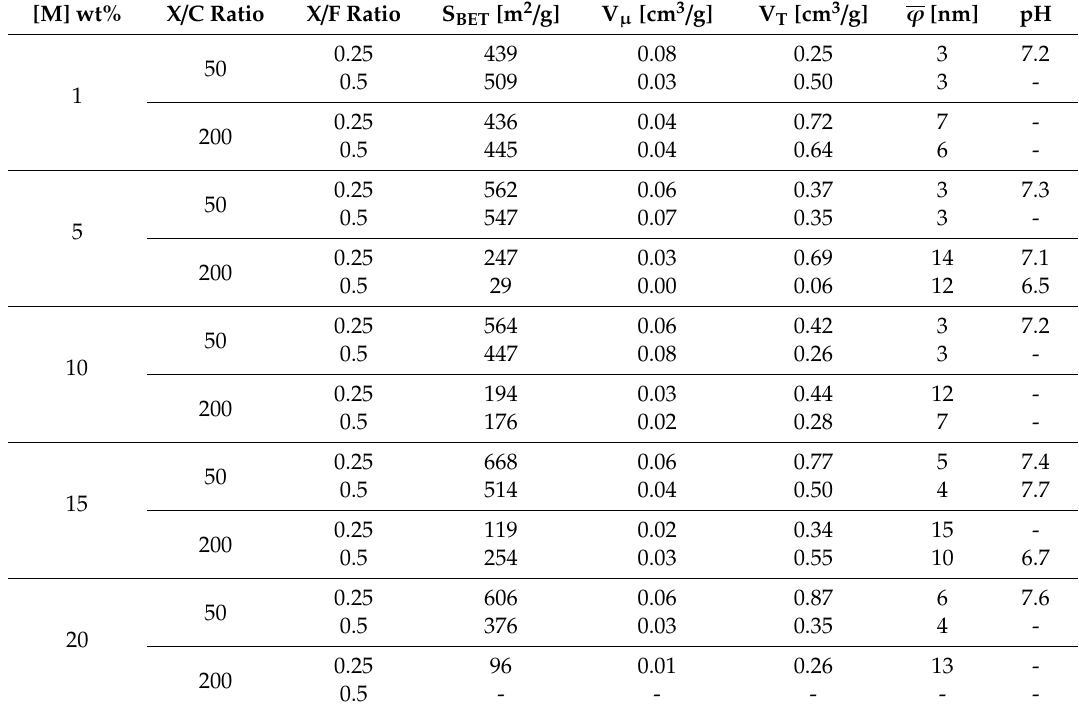
Table A4. Textural properties and initial reaction mixture pH values for gels with melamine as the additive.